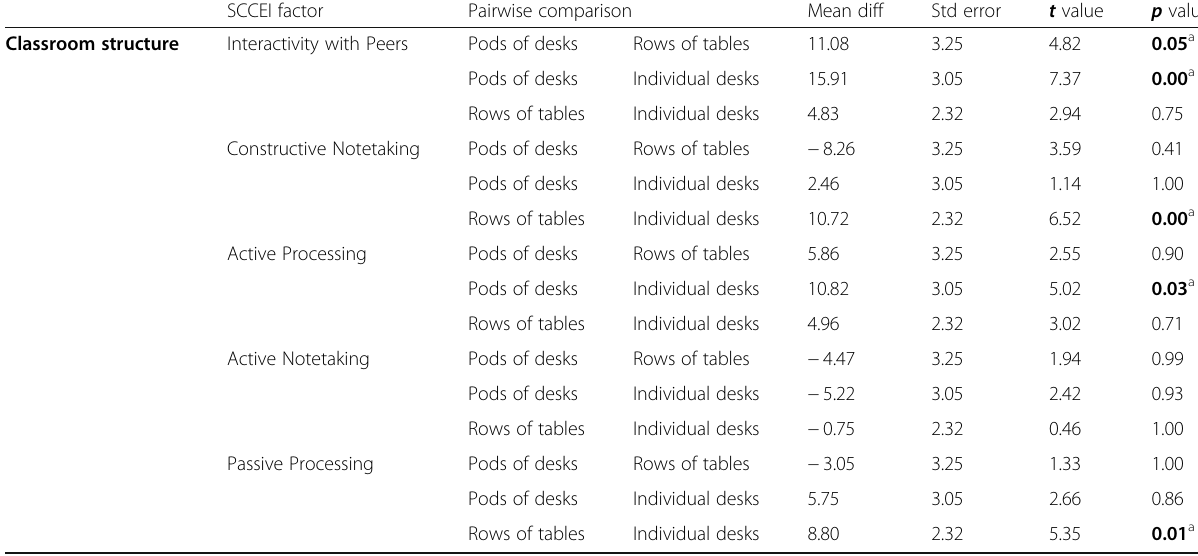
Table 7 Tukey results indicating the significance of pairwise